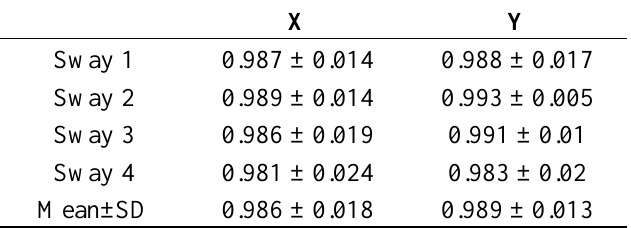
Table 3. The four sway signal correlation results